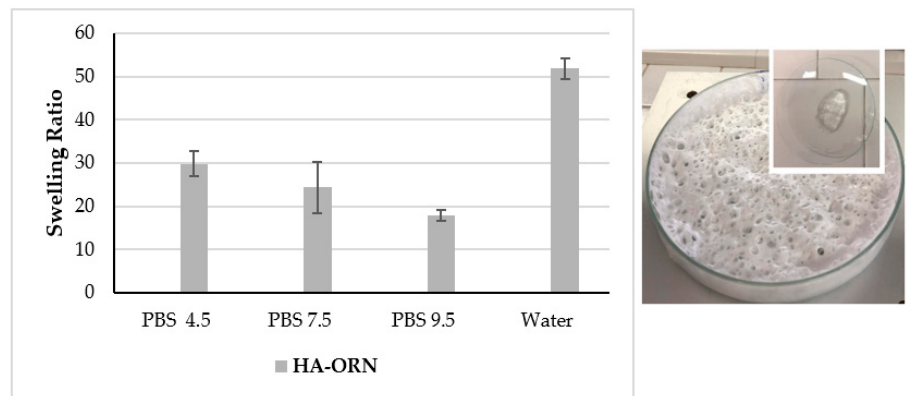
Figure 6. Left: Swelling ratio of HA–Orn at different pH values ( n = 3; mean ± StDev) in PBS. Right: the behavior of HA–Orn before and after the addition of water.